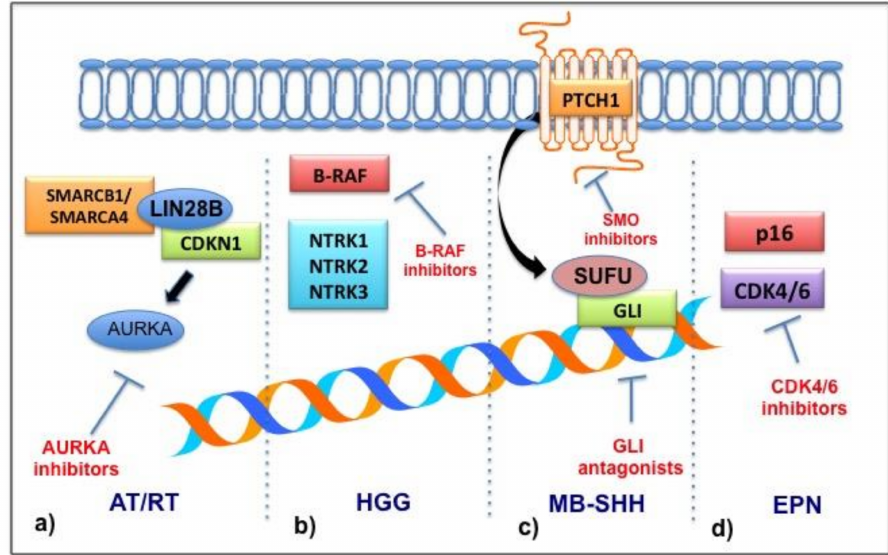
Figure 1. Molecular pathways and potential druggable targets in brain tumors of infants. ( a ) AT/RTs are characterized by the inactivation of SMARCB1 or SMARCA4. These molecules regulate cyclin de- pendent kinase inhibitor 1C (CDKN1C) through LIN28B that upregulates aurora kinase A (AURKA). ( b ) BRAF mutations have been detected in HGGs and LGG and BRAF inhibitors have proven effec- tive. Gene fusions involving the neurotrophin receptor tyrosine kinase genes 1–3 (NTRK1, NTRK2 and NTRK3) have been identified in HGGs and new anti-TRK drugs are promising. ( c ) Inactivating mutations of PTCH1 or SUFU characterize the subgroup SHH of a medulloblastoma. As SUFU is a negative regulator of the glioma-associated oncogene (GLI) transcriptional factors that activate the Hedgehog (HH) pathway, GLI antagonists are new potential targeted drugs. ( d ) The loss of p16 in ependymoma leads to the activation of the p16-CDK4/6-pRB-E2F pathway, suggesting a potential role of CDK4/6 inhibitors. AT/TR: atypical teratoid rhabdoid tumor; HGG: high-grade glioma; MB-SHH: medulloblastoma, subgroup SHH; EPN: